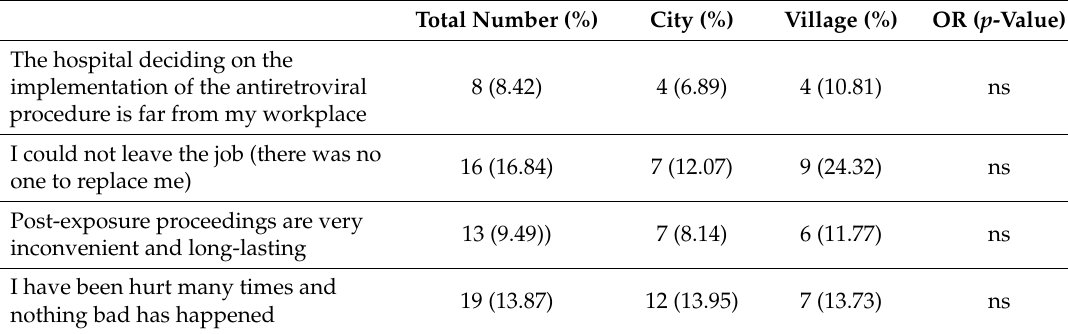
Table 5. The most common reasons for not implementing post-exposure proceedings, ( N =